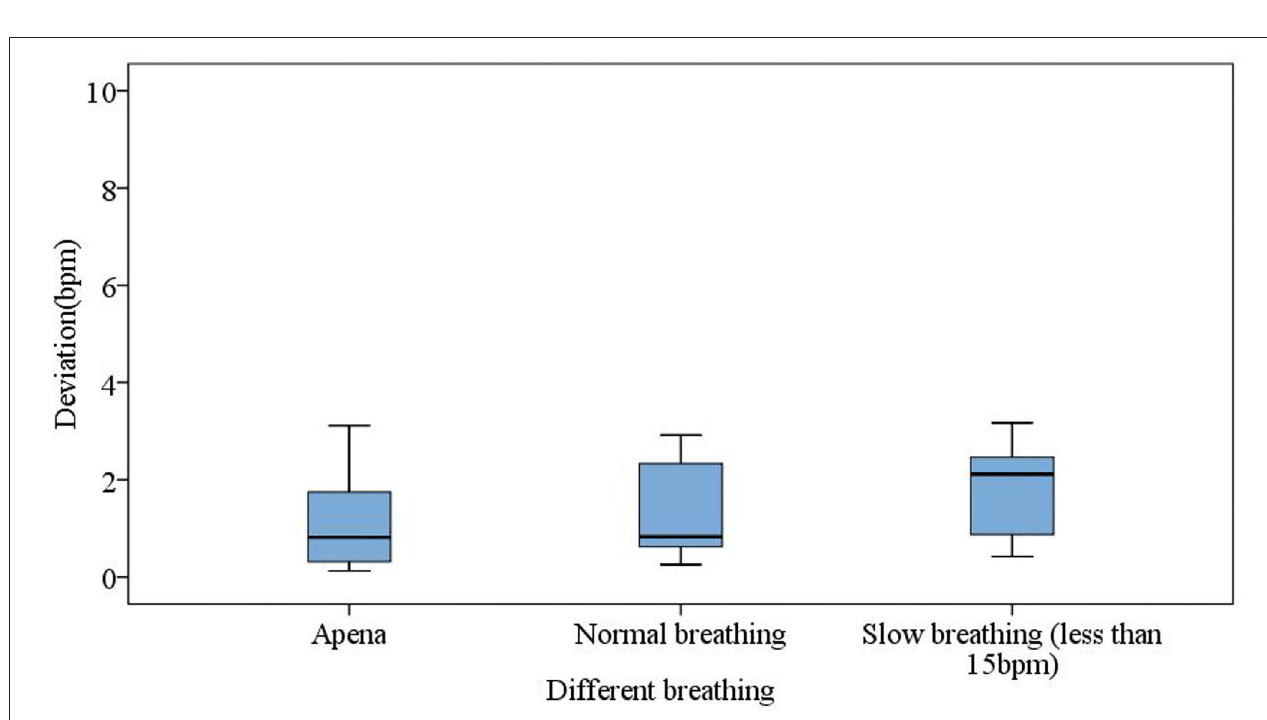
FIGURE 11 | Different breathing states for apnea (breath holding), normal respiration, and slow respiration.